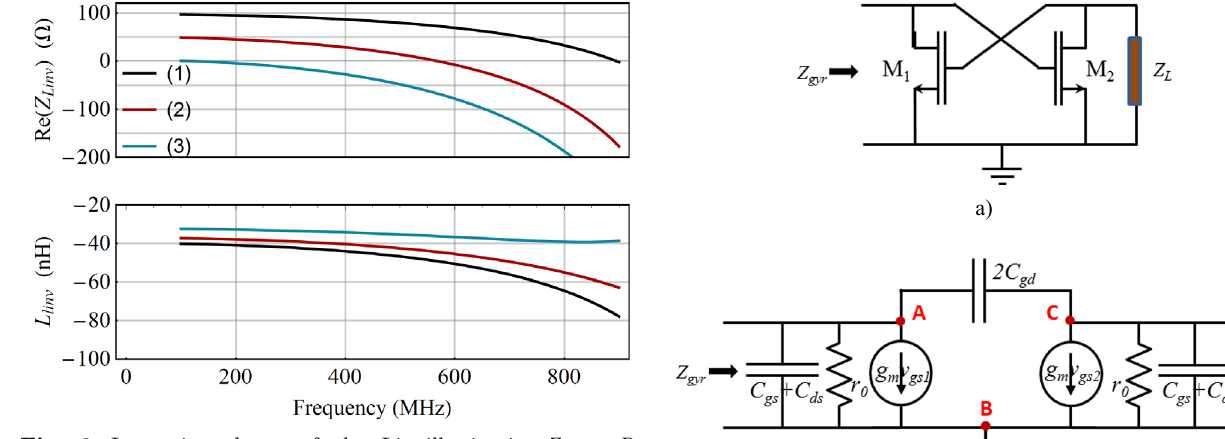
Fig. 8. Input impedance of the Linvill circuit, Z Linv = Re ( Z Linv )+ jL Linv v , assuming g m = 20mS, L =40 nH and: (1) R =0 V , f Re0 =900 MHz (2) R =50 V , f Re0 =570 MHz; (3) R =100 V , f Re0 =120 MHz. Fig. 9. a) Gyrator circuit with MOSFET transistors. b) Small- signal model of the gyrator